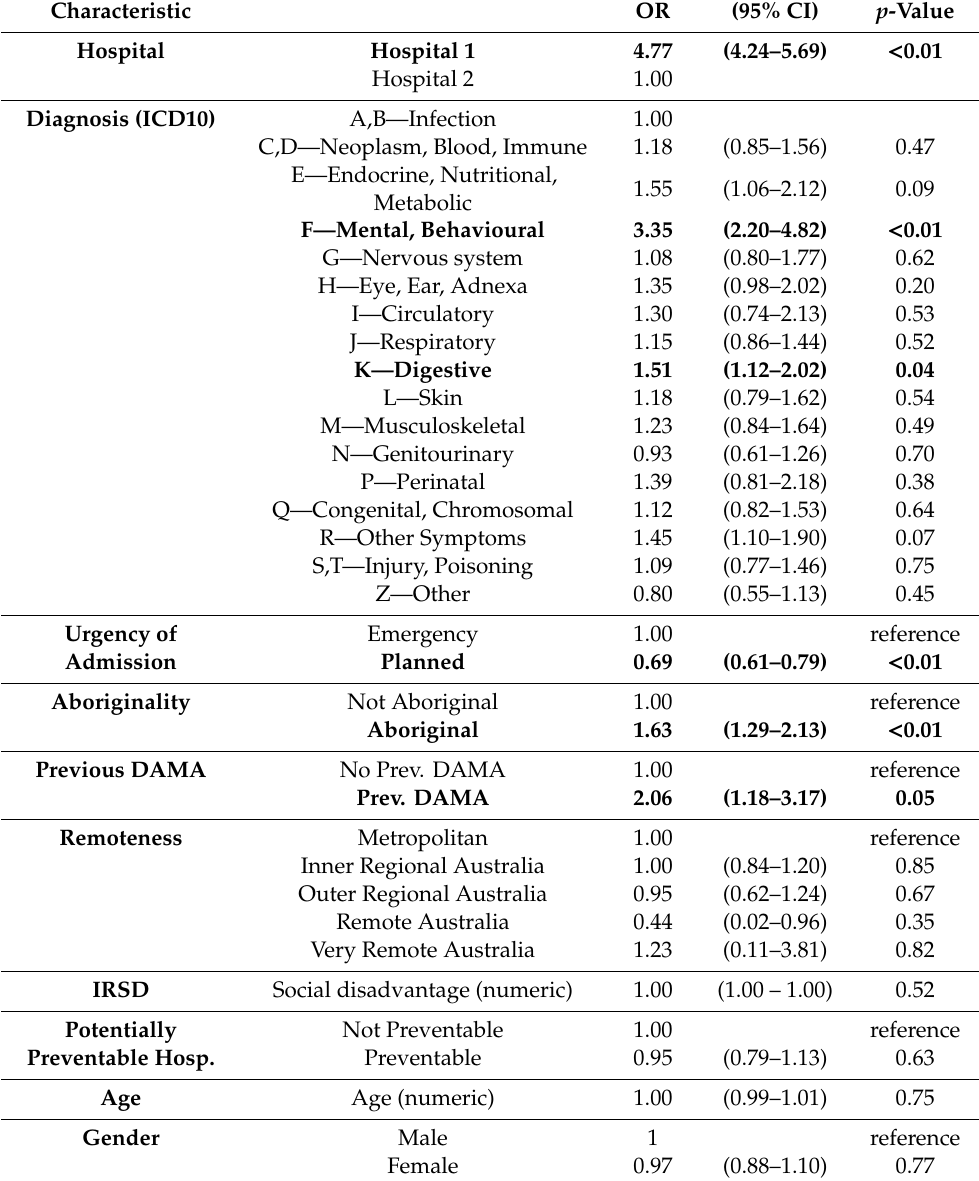
Table 3. Predictors of DAMA per admission (Bayesian multivariable logistic